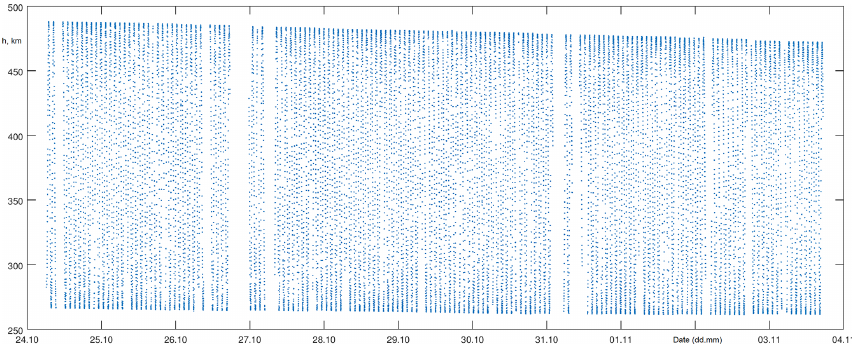
Figure 4. The dependence of Kosmos-49 altitude on time.